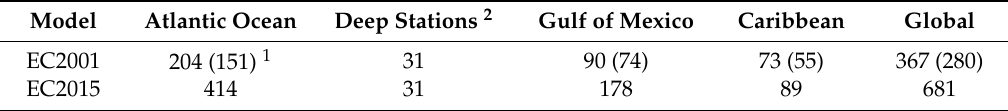
Table 5. Total number of validation stations available in each region for the most recent East Coast